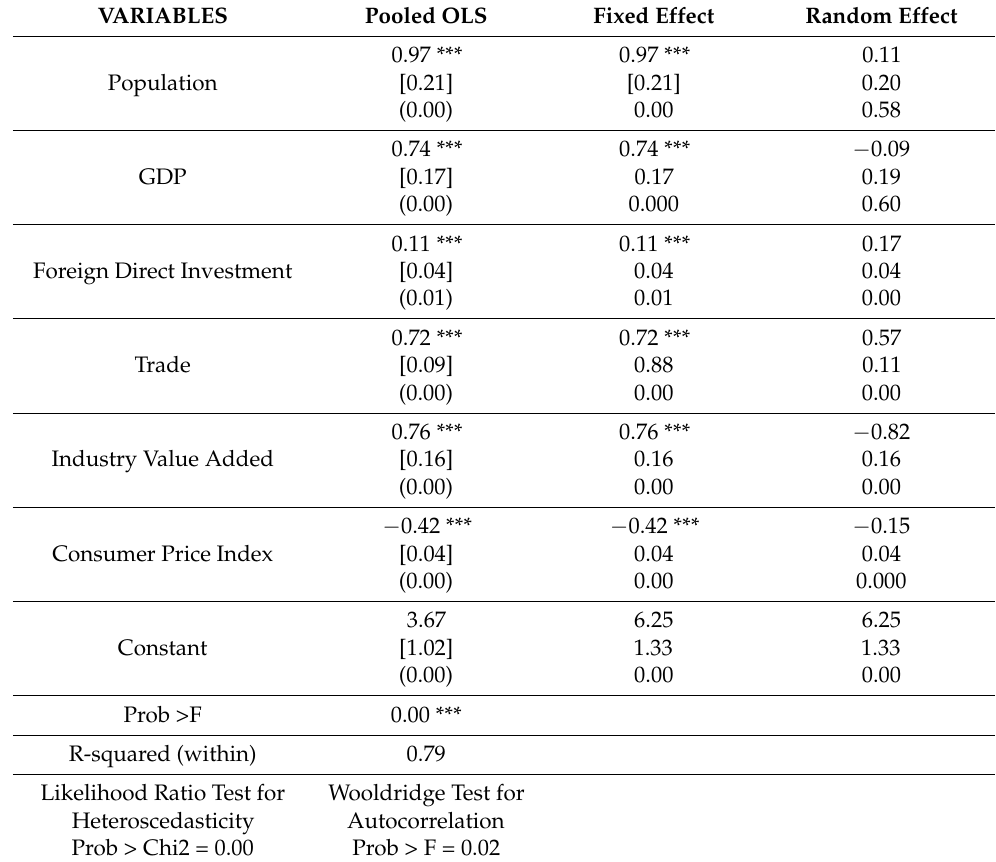
Table 4. Results from pooled OLS